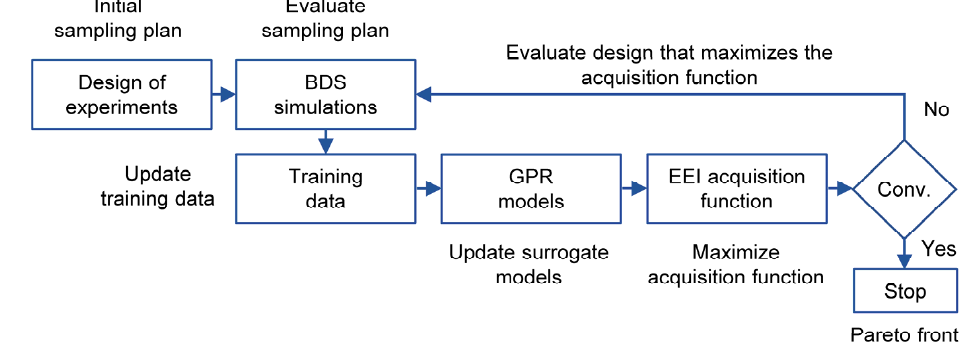
Figure 4. Bayesian optimization framework for the design of lithium ‐ ion battery cells.